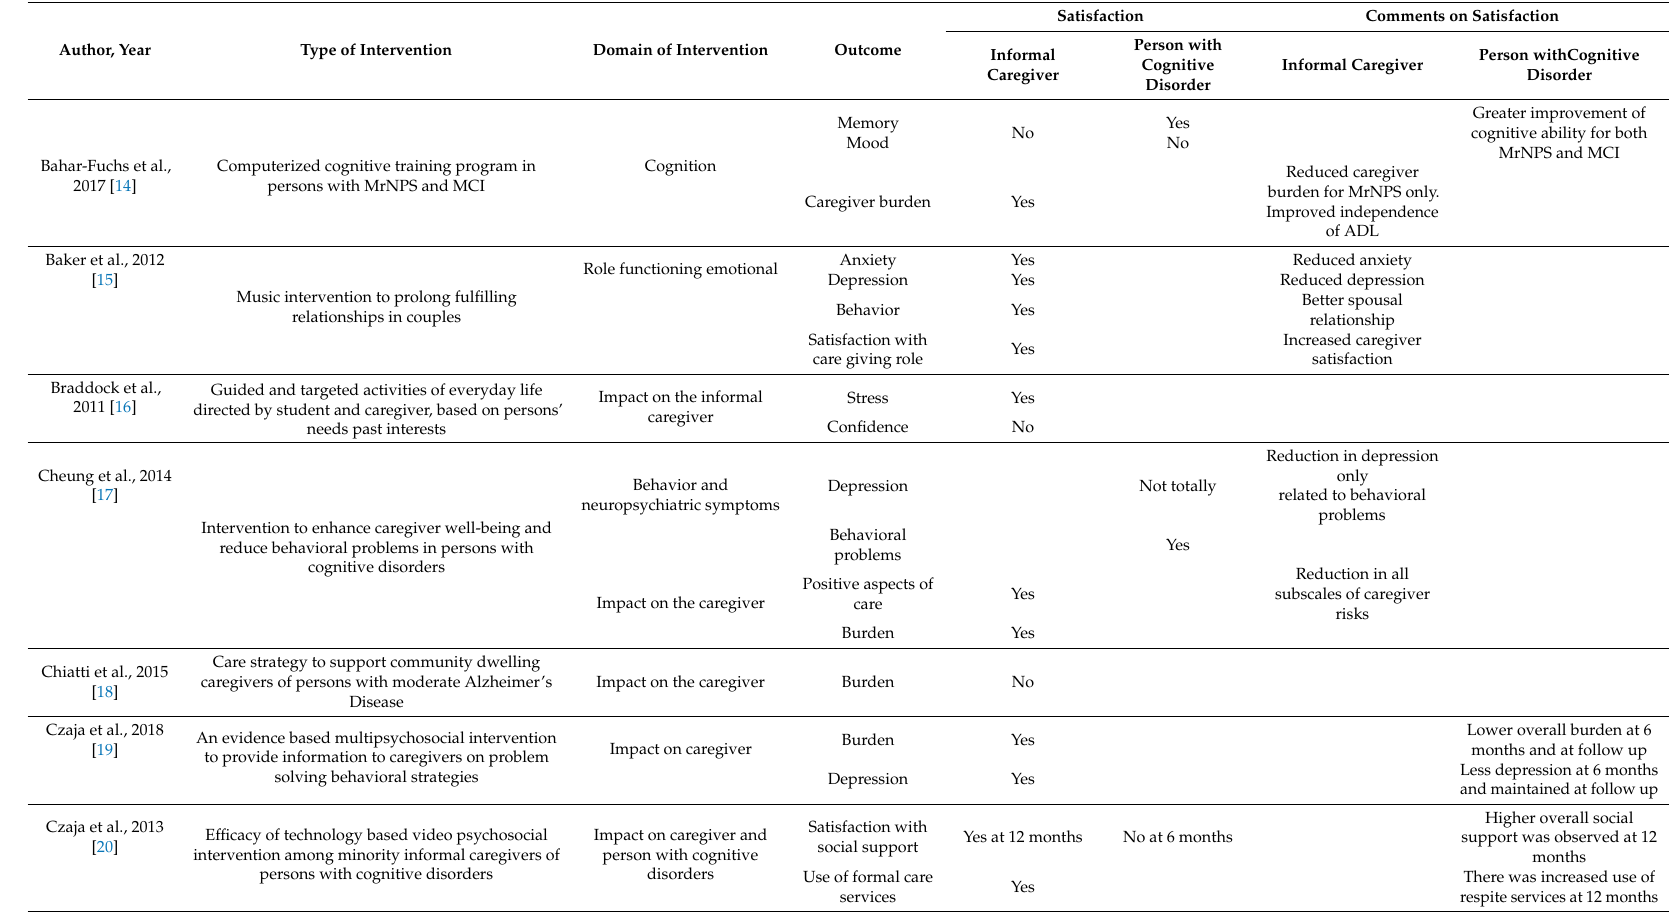
Table 2. Satisfaction with the interventions